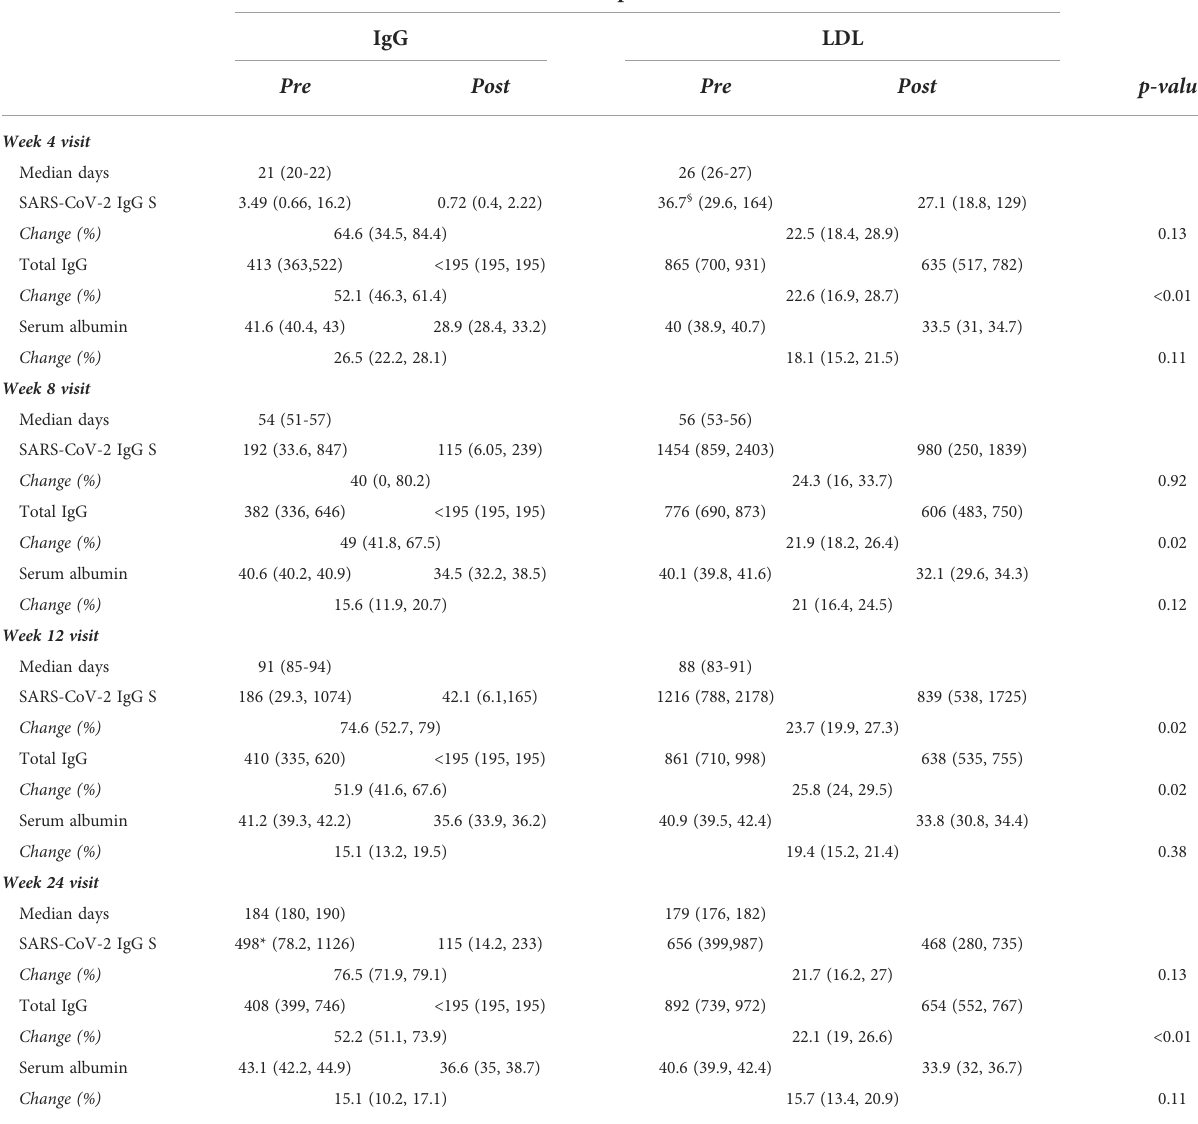
TABLE 3 SARS-CoV-2 IgG spike (S) protein antibody levels (U/mL), total IgG levels (mg/dL), and serum albumin levels (g/L) pre vs. post treatment and respective change (%) per treatment and time period after the fi rst vaccination in 6 patients receiving IgG apheresis and 18 patients receiving LDL apheresis,